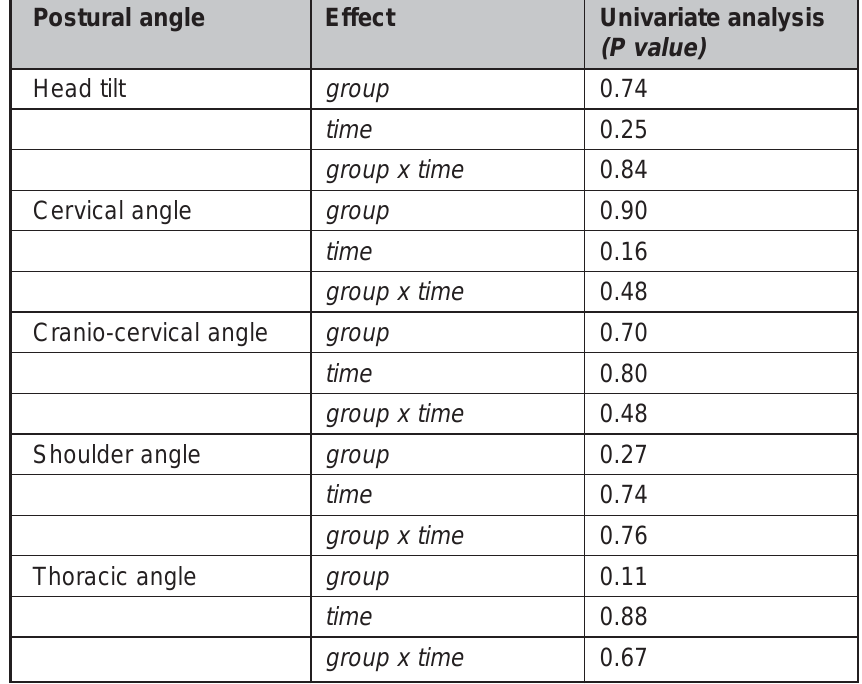
Table 3: Summary of the univariate analysis for the postural